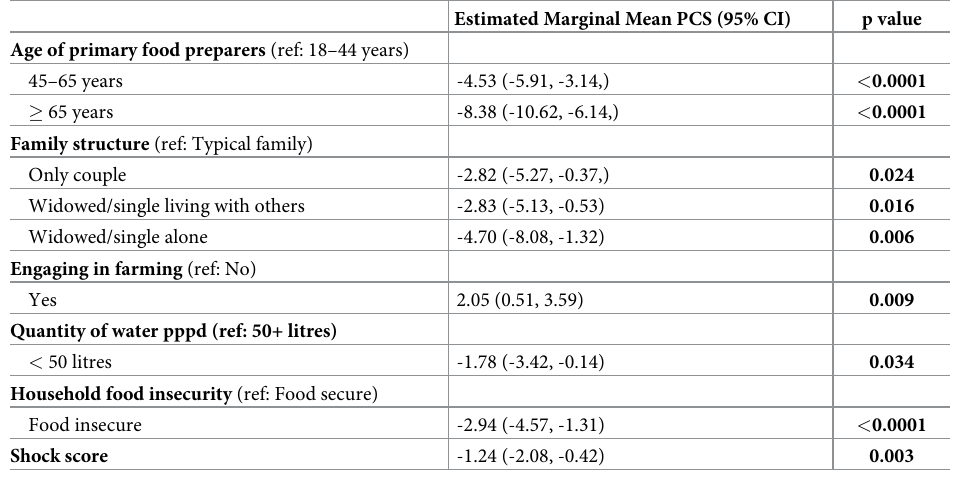
Table 3. Factors associated with PCS in multivariable general linear